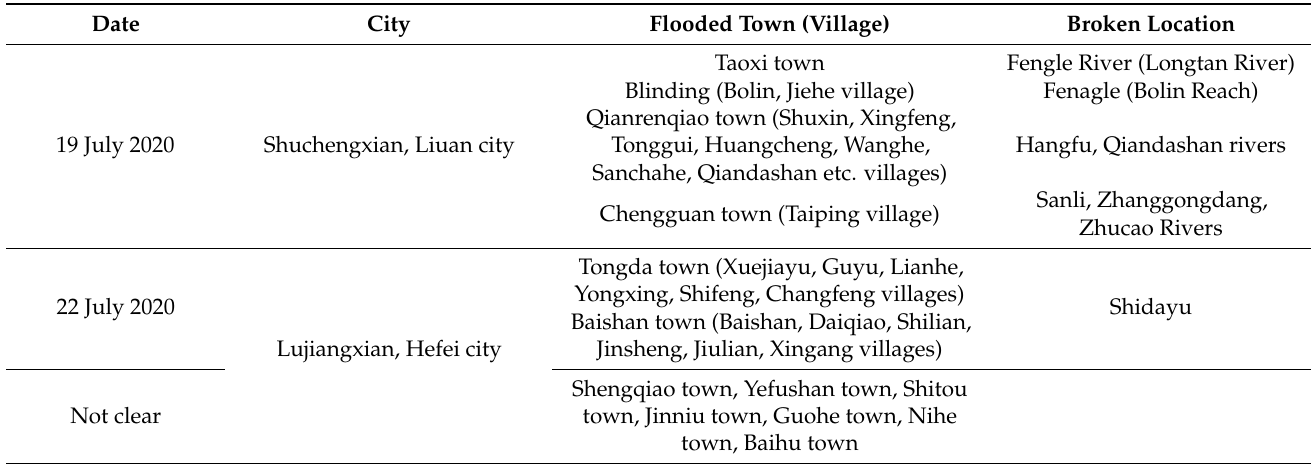
Table A2. The flood- and damage-relevant information from Baidu News in the study area.